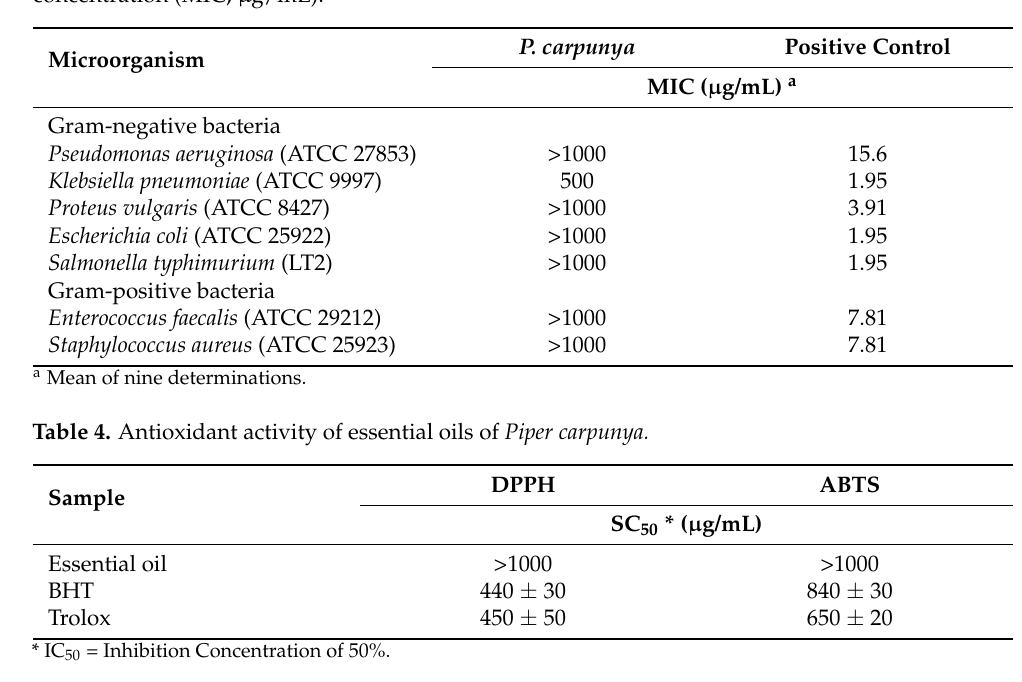
Table 3. Antibacterial activity of essential oil from Piper carpunya , given as minimal inhibitory concentration (MIC, µ g/mL).